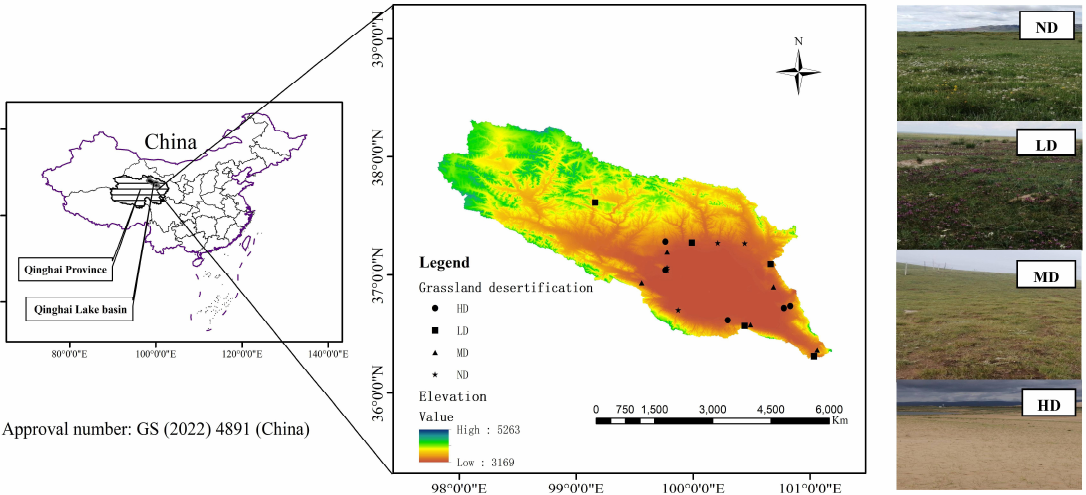
Figure 6. Location diagram and sample setting of Qinghai Lake Basin (China). The figure on the left shows the geographical position of Qinghai Province in China and the Qinghai Lake Basin in Qinghai Province. Meanwhile, our survey plots are also marked in the geographical map of Qinghai Lake basin. On the right, from top to bottom, are the habitat photos of not (ND), light (LD), moderate (MD) and heavy (HD) desertification plots. The dataset of Qinghai Lake Basin is provided by National Cryosphere Desert Data Center. (http://www.ncdc.ac.cn (accessed on 17 August